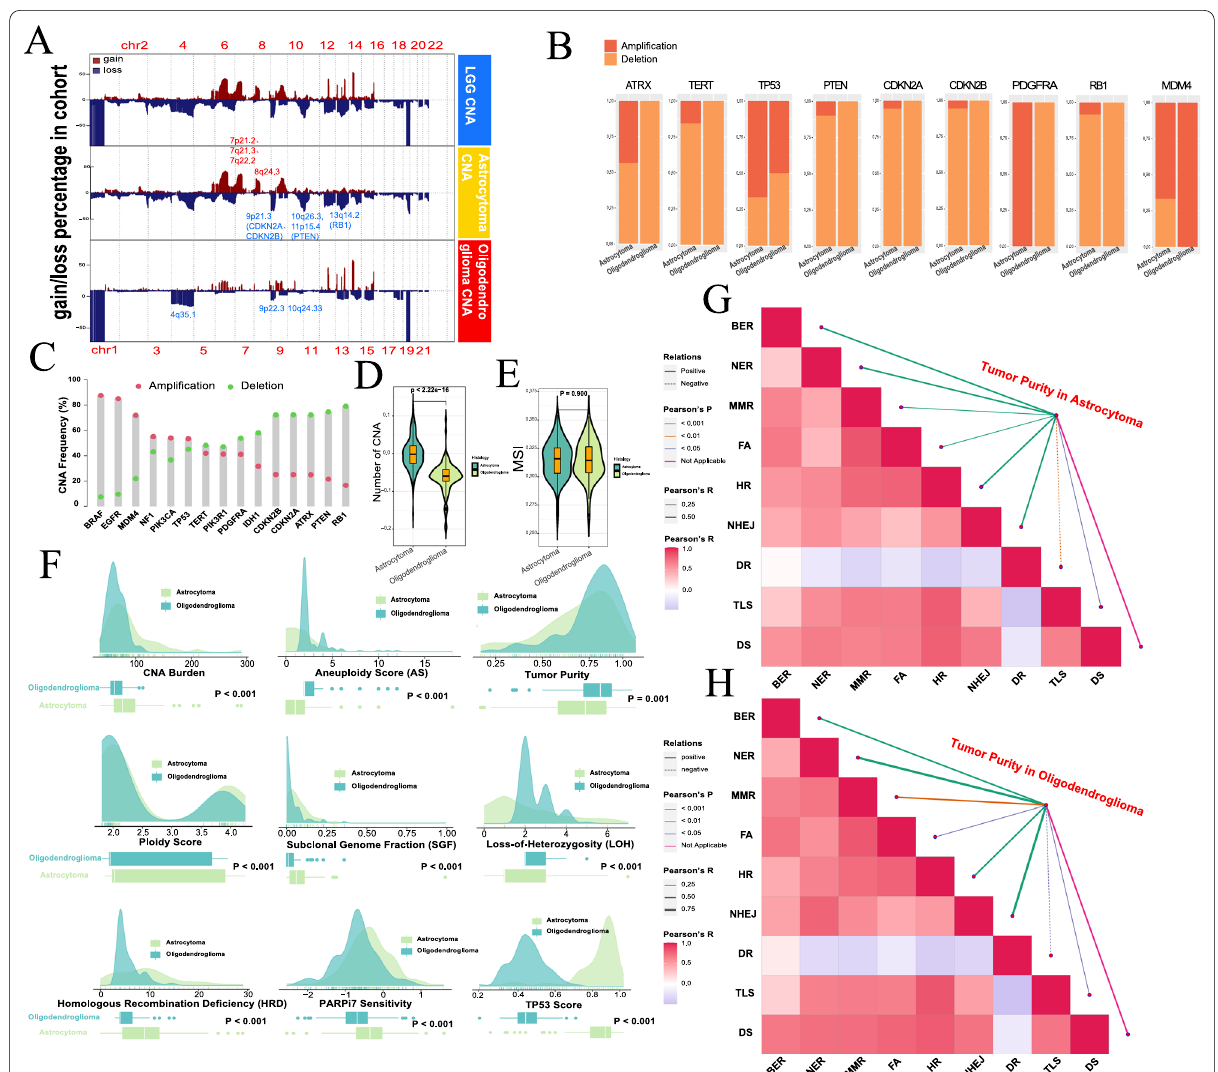
Fig. 2 Copy number alterations and DNA damage repair-related signatures. A Genomic overview showing the percentage of samples with CNA in astrocytoma, oligodendroglioma and astrocytoma oligodendroglioma. Some landmark genes and their locations are depicted. B Proportion + of amplification and deletion of key genes/driver genes between astrocytoma and oligodendroglioma. C Rankings of CNA frequency referring to gain and loss status in astrocytoma oligodendroglioma. D Number of CNAs between astrocytoma and oligodendroglioma (Wilcoxon + P < 2.22e 16). E MSI between astrocytoma and oligodendroglioma (P 0.900). F Quantification of DDR-related signatures in astrocytoma and − = oligodendroglioma (Wilcoxon rank-sum test). G Correlation between DDR-related pathways and tumor purity in astrocytoma. H Correlation between DDR-related pathways and tumor purity in oligodendroglioma. Pearson’s correlation analyses were conducted between tumor purity of astrocytoma/oligodendroglioma and each DDR-related pathway, and among the pathways. The coefficients were reported respectively. CNA copy number alternation, AS aneuploidy score, DDR DNA damage repair, SGF subclonal genome fraction, LOH loss-of-heterozygosity, HRD homologous recombination defect, PARPi poly (ADP-ribose) polymerase inhibitors, BER base excision repair, NER nucleotide excision repair, MMR mismatch repair, FA Fanconi anemia, HR homologous recombination, NHEJ nonhomologous end joining, DR direct repair, TLS translesion synthesis, DS damage